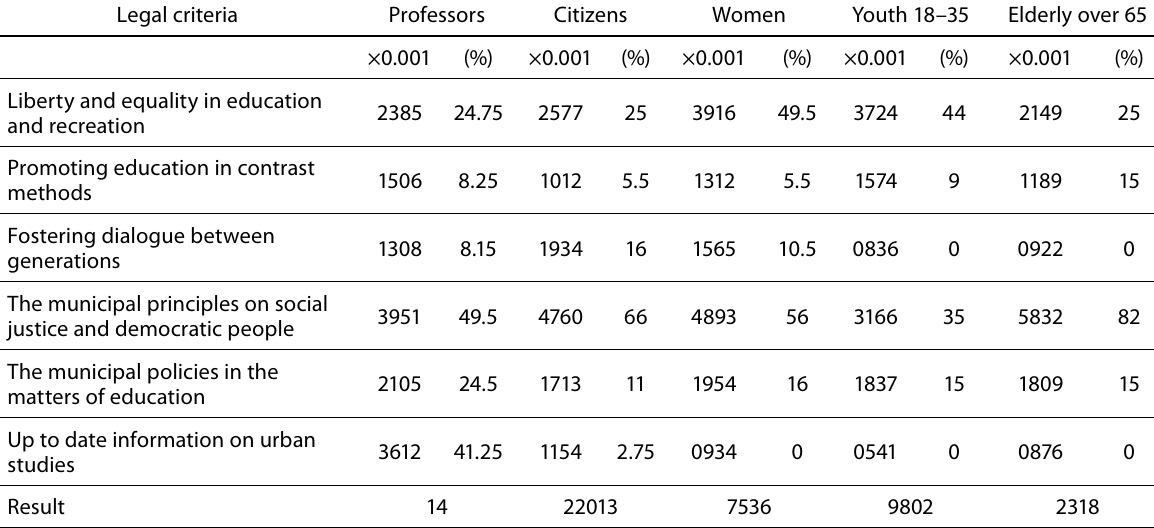
Table 2. analyzing the right to have an educating city principles in Tehran legal